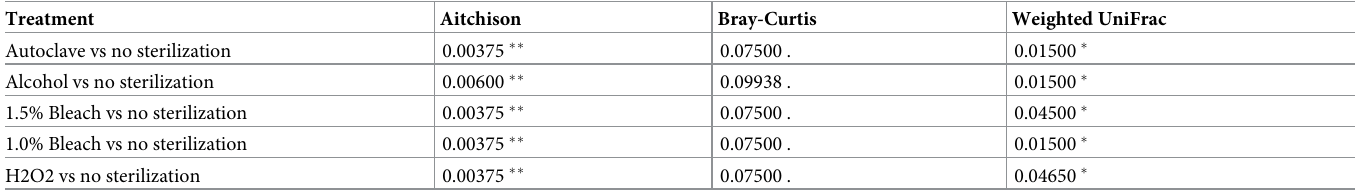
Table 3. Adjusted P-values from PERMANOVA tests of beta diversity indices looking at simulated in vitro colonic fermentations. Each treatment groups all four pulse types